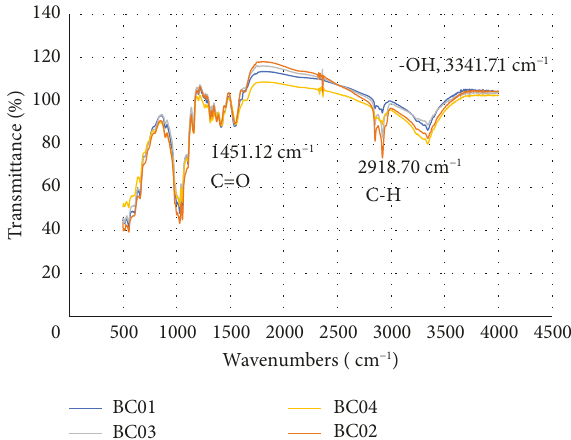
Figure 8: FTIR of bacterial cellulosic membranes under various sonication temperatures: BC01—55 ° C, BC02—60 ° C, BC03—65 ° C, and BC04—70 ° C.